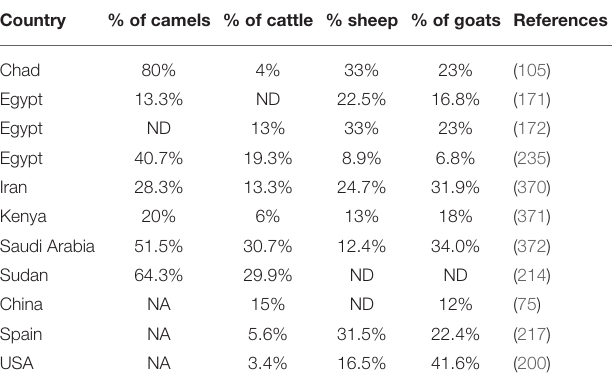
TABLE 3 | The seroprevalence of Coxiella burnetii in Camelus dromedarius camels compared to other ruminants.